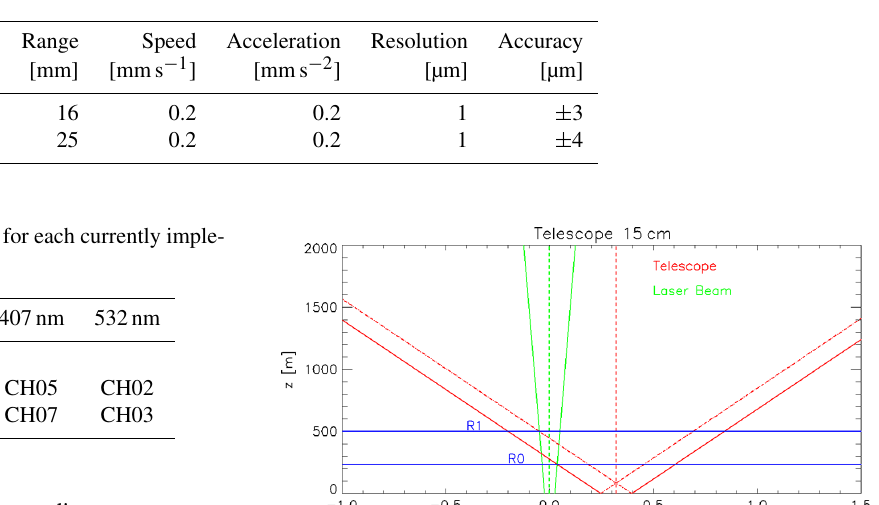
Table 3. Nominal characteristics of the servomotors.